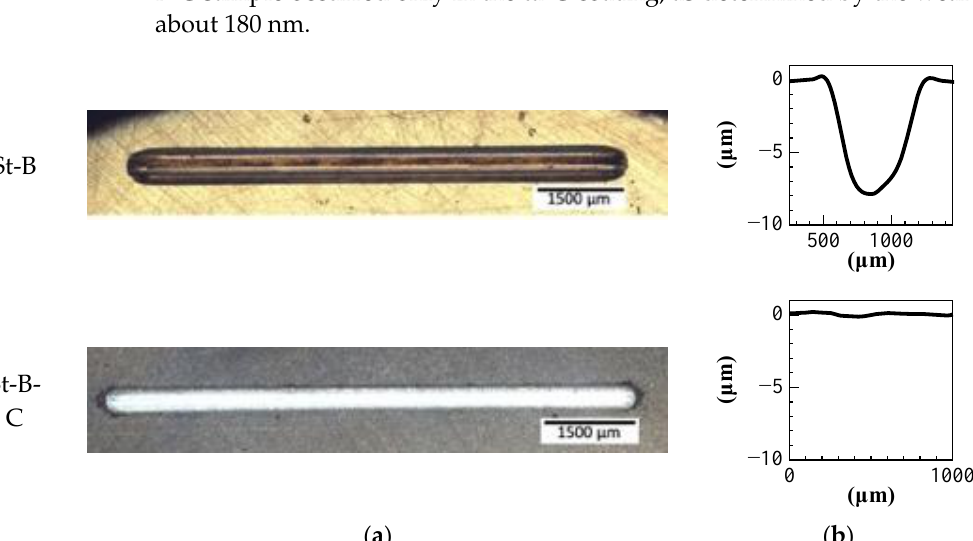
Figure 5. Optical microscopy images ( a ) and cross-section profiles ( b ) of sample wear tracks for St-B and St-B-C.